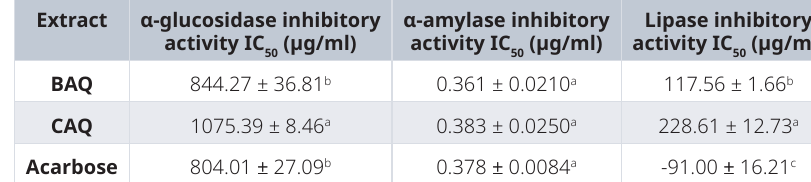
Table 1. IC (µg/ml) values of α-amylase, α-glucosidase, and lipase inhibitory 50 activities of the BAQ and CAQ extracts of H. petiolare.